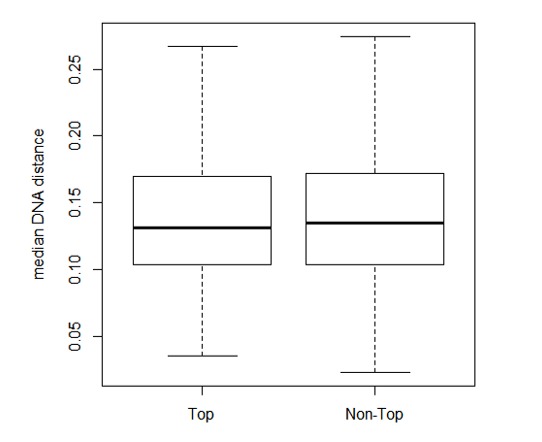
DOI:
http://dx.doi.org/10.7554/eLife.19130.017